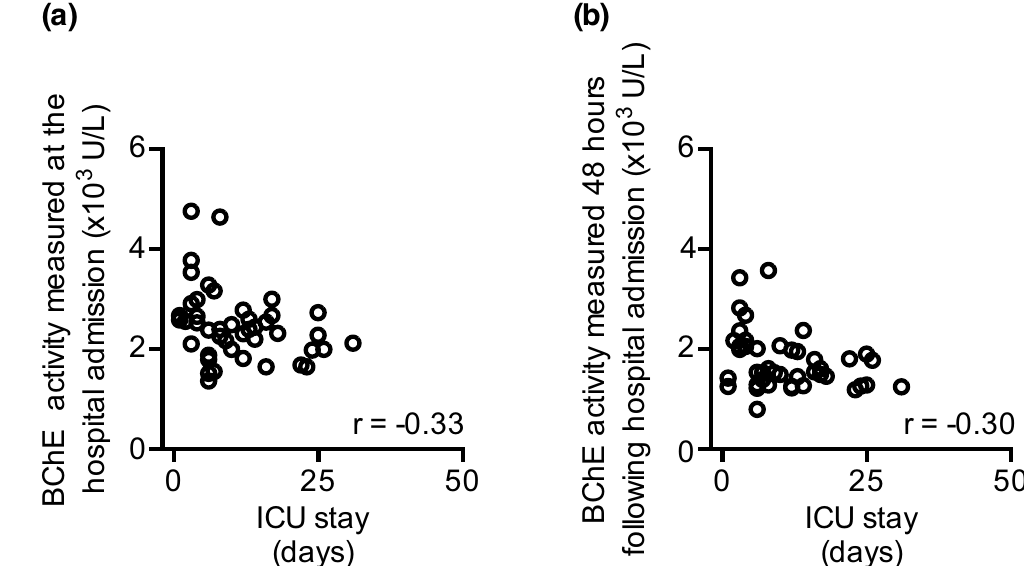
Figure 4. The activity of BChE measured at hospital admission correlates with the length of ICU stay in patients with major traumatic injury. The activity of BChE measured from trauma patients at hospital admission ( a ) and 48 hours later ( b ) correlates with their length of the ICU stay. r – Spearman correlation coefficient; ICU – intensive care